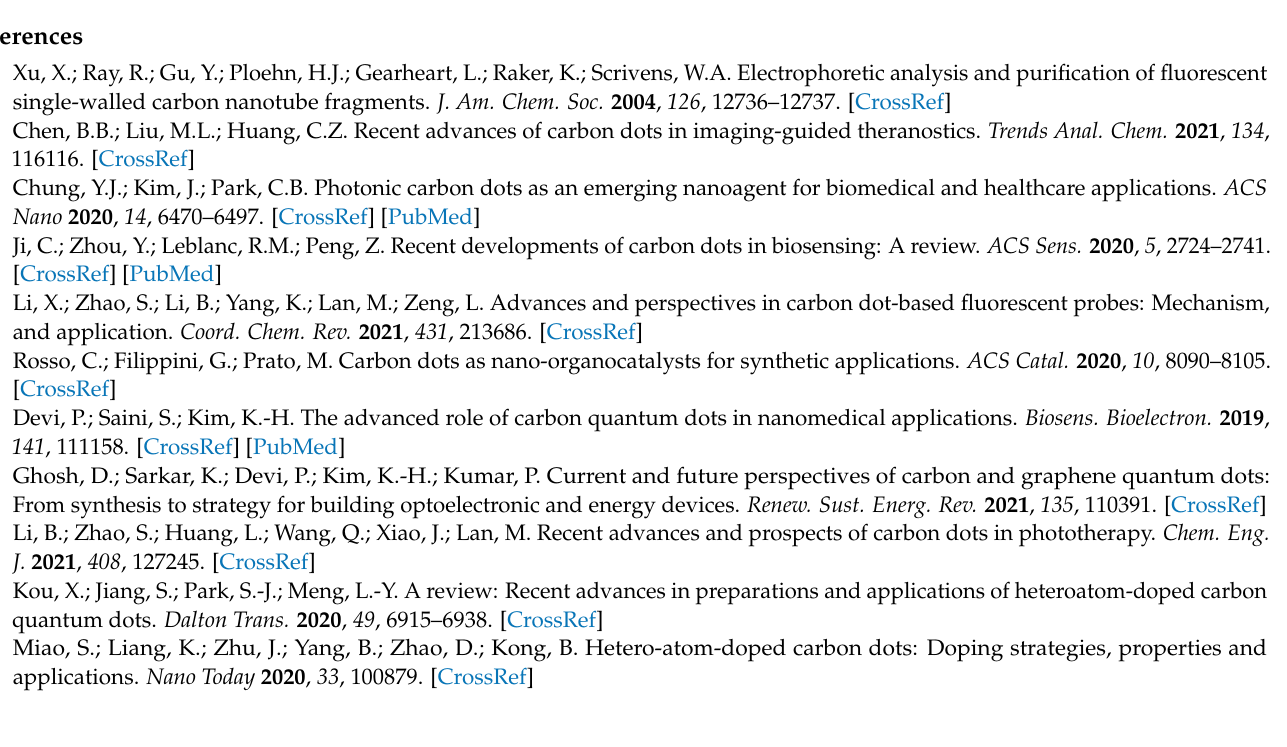
Table S3: Comparison of different fluorescent CDs applied for ClO –